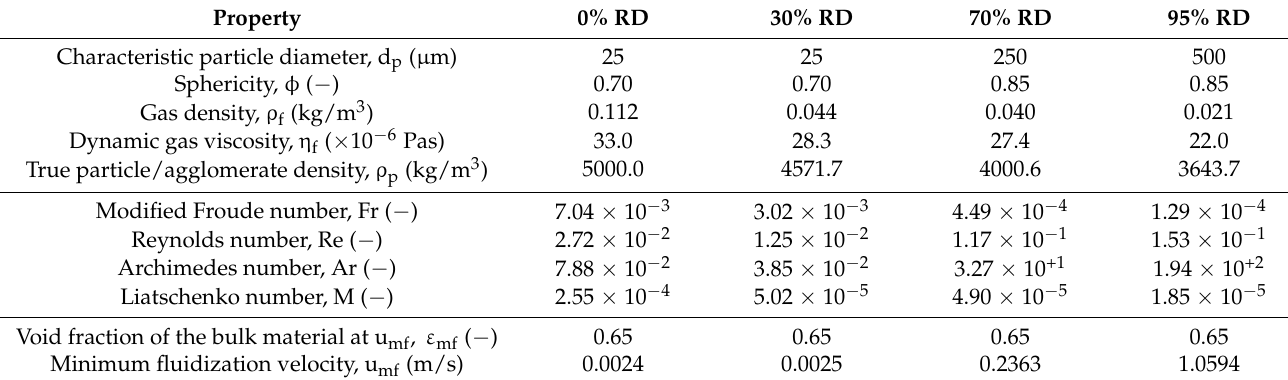
Table A3. Changing gas and bed material properties, dimensionless numbers, and minimum flu- idization velocity for reduction at 873 K and the formation of